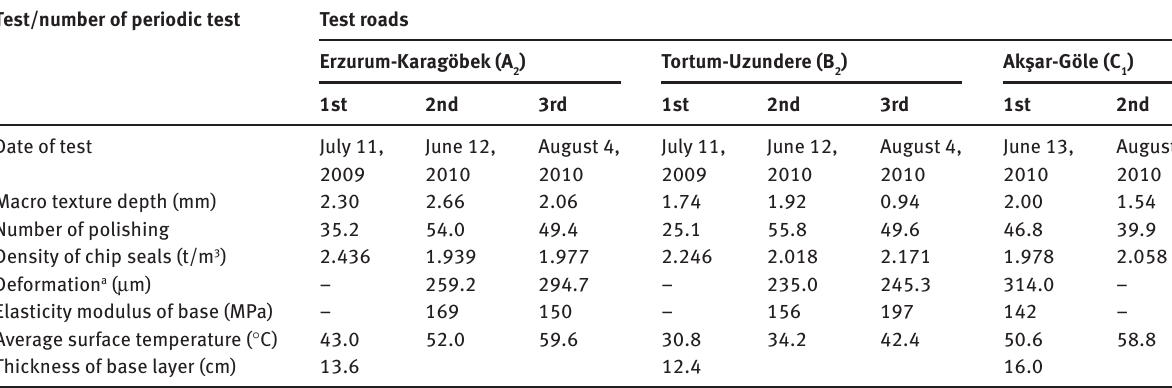
Table 6: Nondestructive test results of right wheel path’s (1)